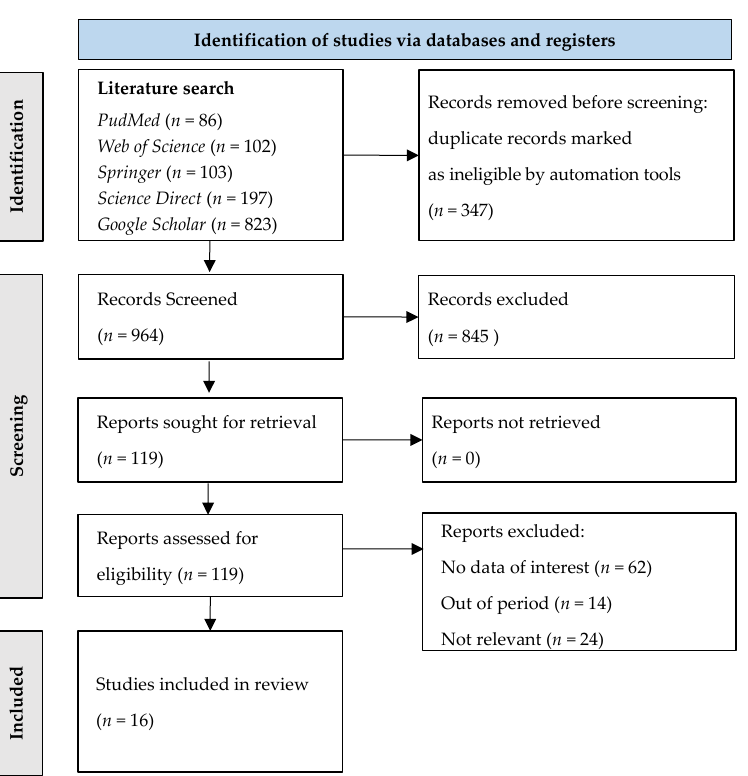
Figure 5. PRISMA flow diagram showing the search and selection process.